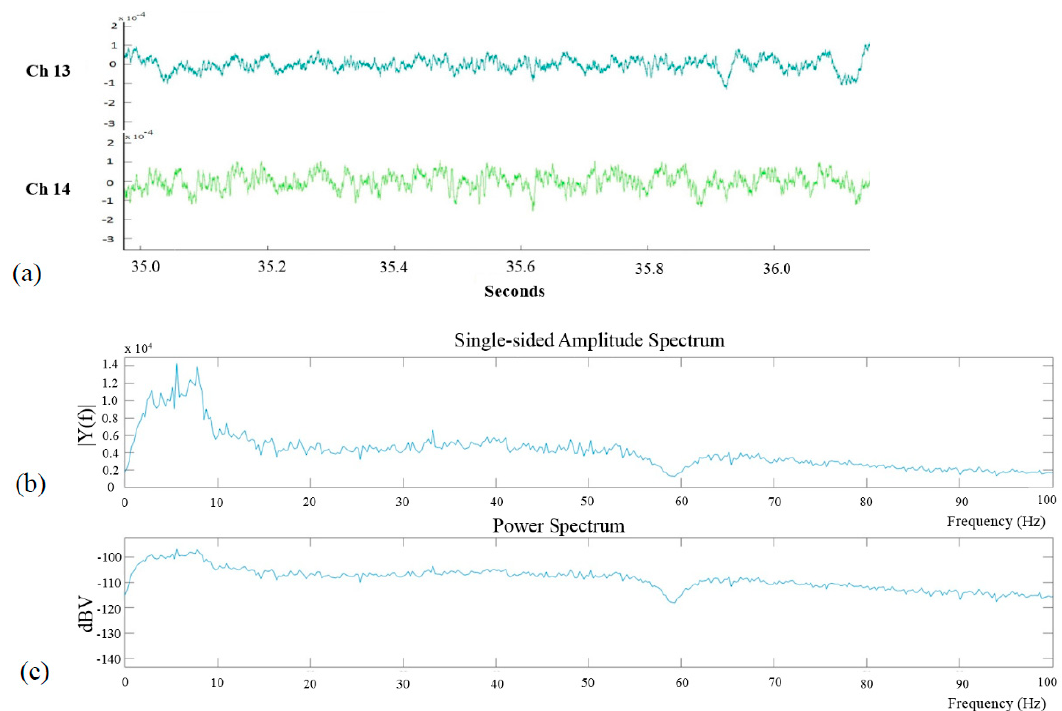
Figure 5. A detailed view of the recorded signals. ( a ) Peak-to-peak amplitudes are around 200 µV. This plot shows 1 s period signal patterns which demonstrated the traditional local field potential patterns; ( b ) Single-sided voltage amplitude in the frequency spectrum; ( c ) Relative power of the local field potentials (LFP) frequency spectra. A notch filter to remove 60 Hz noise was used during the recording which showed as a deep dent at 60 Hz in the frequency spectrum.